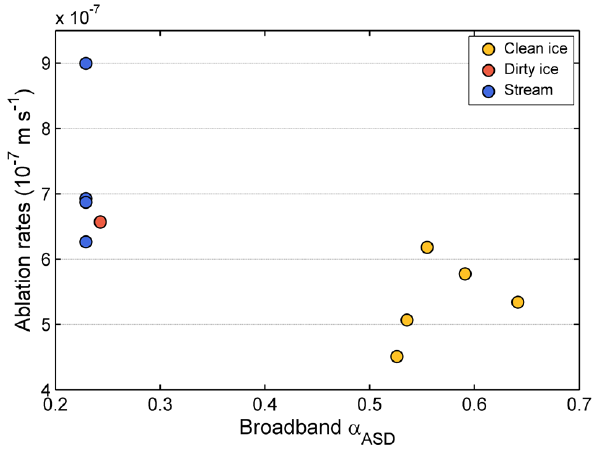
Figure 12. MODIS 2013 seasonal average for the 100 × 100px spa- tial extent. Overall higher MODIS albedo values are observed in 2013 without a “dark-band” region surface expression.